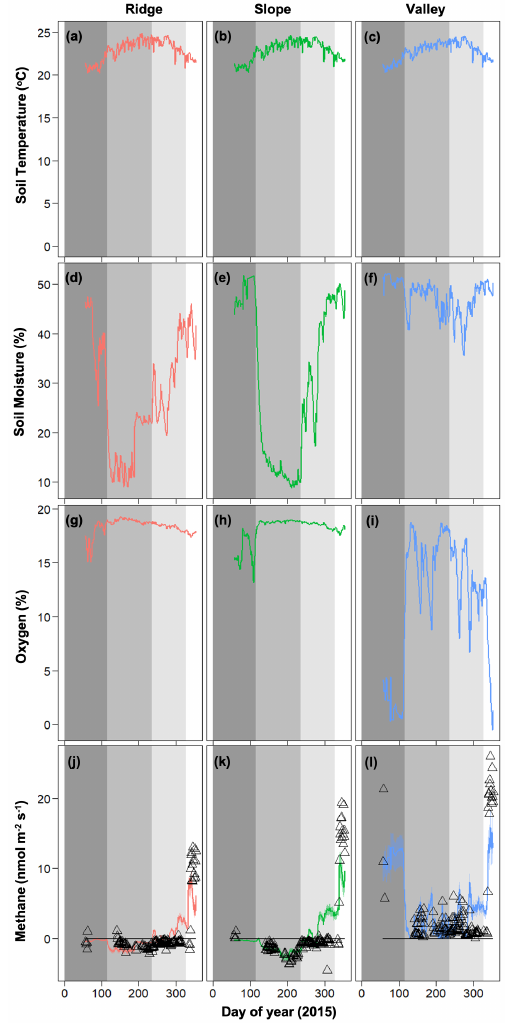
Figure 3. Temporal dynamics of observed meteorological drivers (soil temperature, a–c ; soil moisture, d–f ; soil oxygen, g–i ) and net methane emissions (j–l) for 2015 (Data are taken from O’Connell et al., 2018). For methane emissions, symbols represent observed data and lines represent model simulations. Dark gray, medium gray, light gray, and white shading represent pre-drought, drought, drought recovery, and post-drought events (O’Connell et al., 2018).